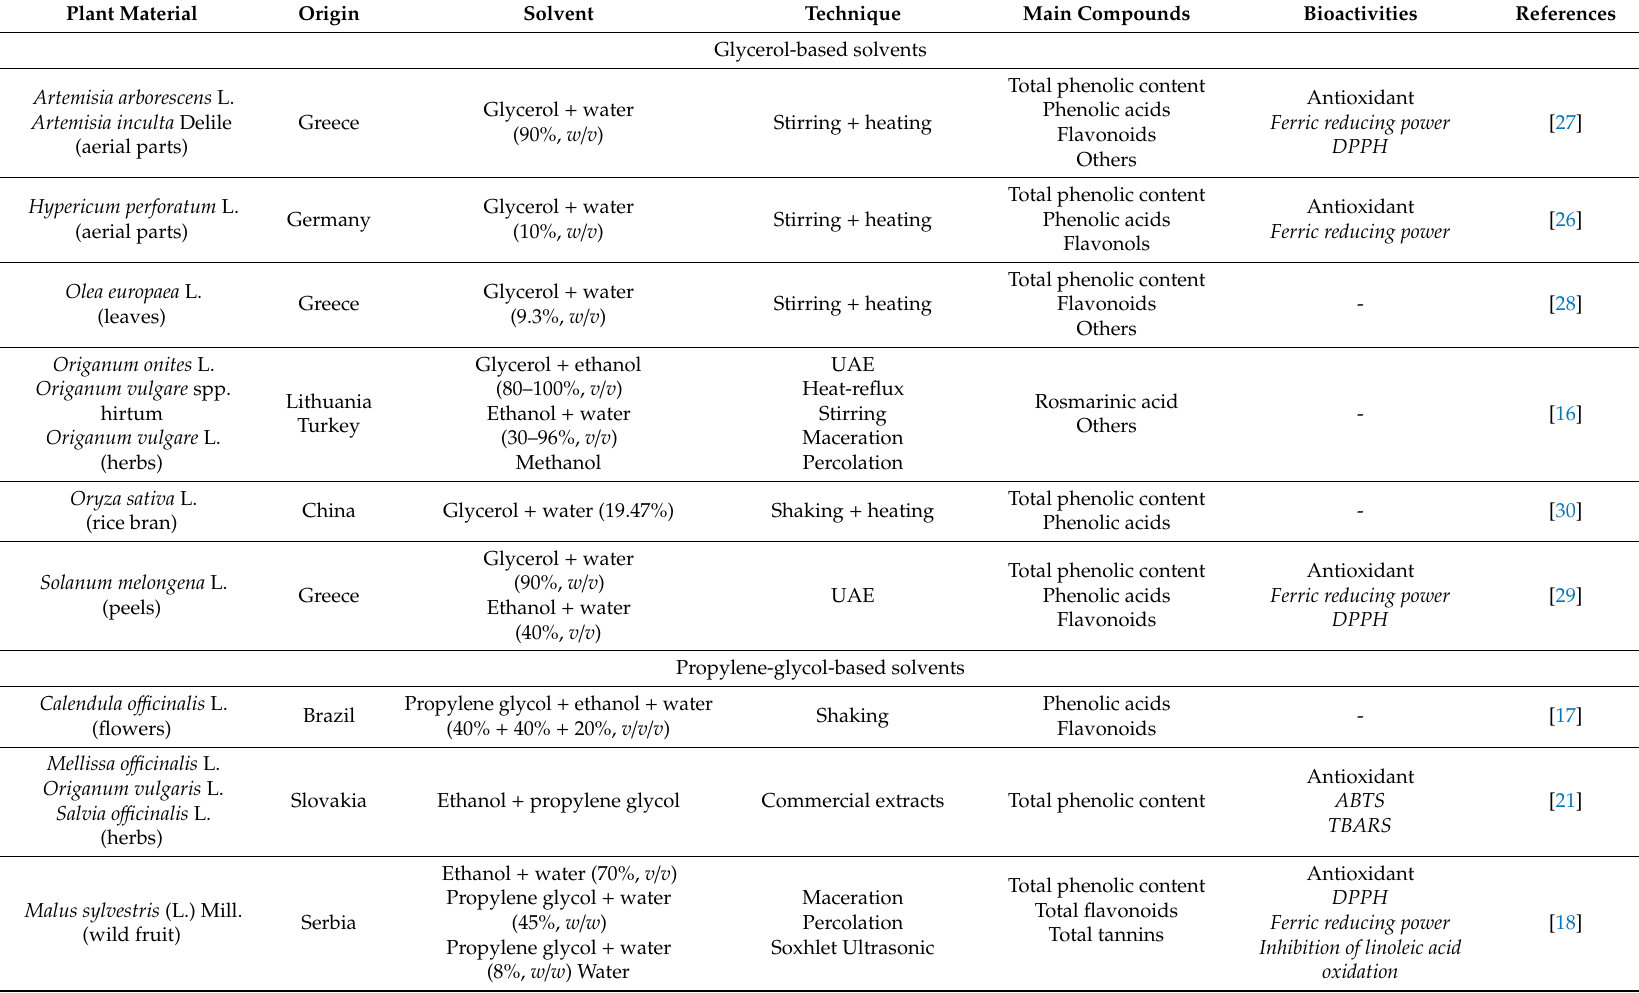
Table 1. Overview of the use of glycerol and alkanediols for the extraction of phenolic compounds from plant